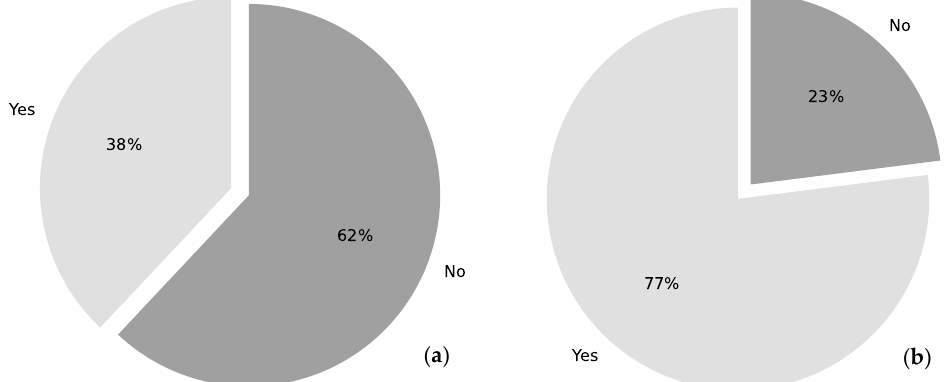
Figure 1. Standardized Protocols Used in CICUs